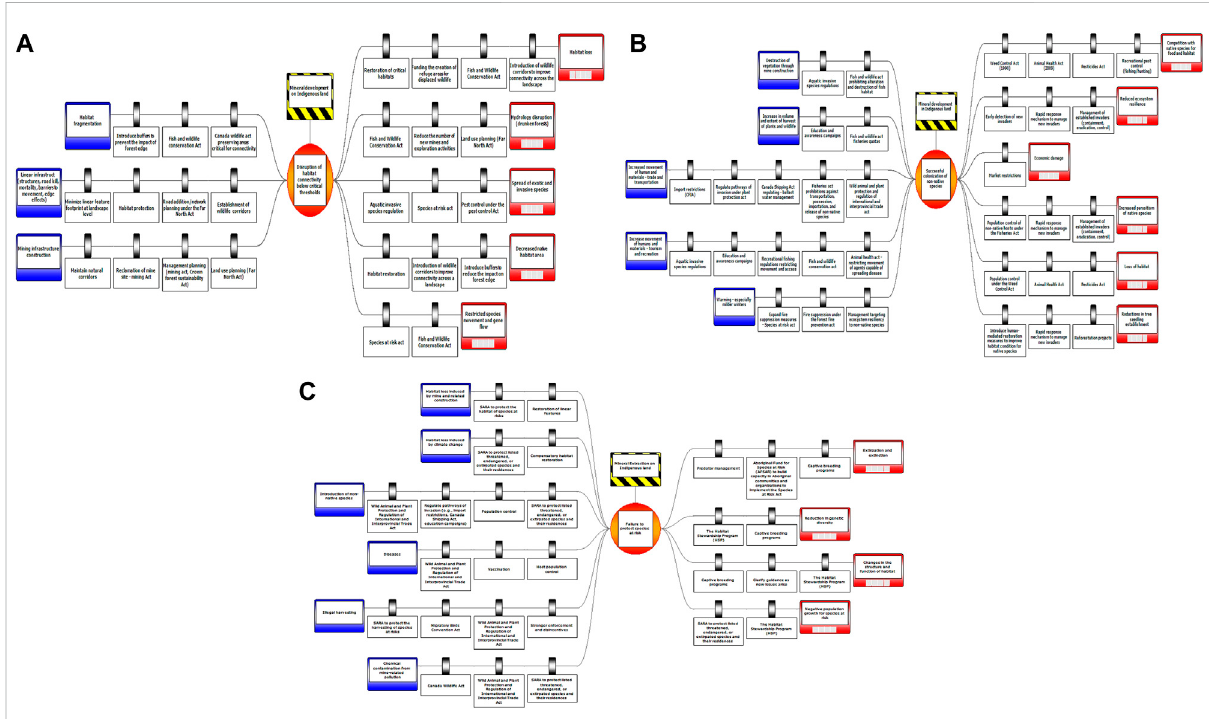
FIGURE 7 Risk Analysis Related to habitat and biodiversity disturbances. (A) Disruption of habitat connectivity below critical thresholds (B) successful colonization of non-native species (C) failure to protect species at